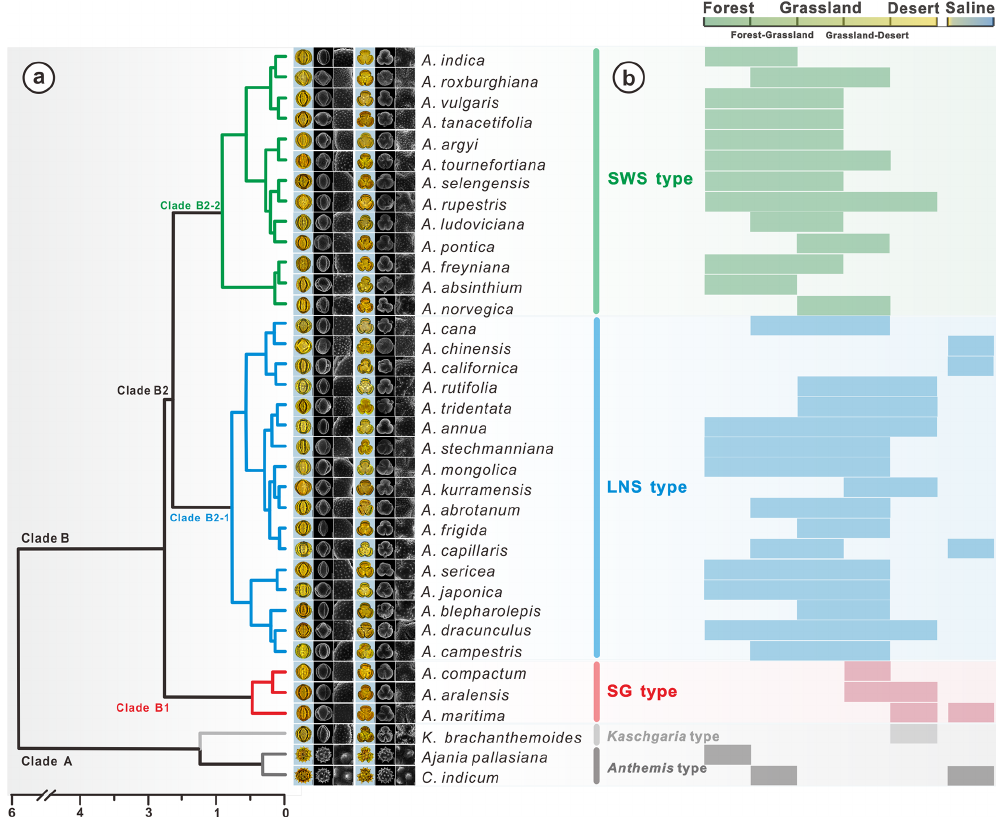
Figure 17. Hierarchical cluster analysis, showing the dendrogram for pollen types from Artemisia and outgroups (a) , and the habitat ranges of 36 representative species (b , Tutin et al., 1976; Zhang, 2007; Ling et al., 2011 ) .